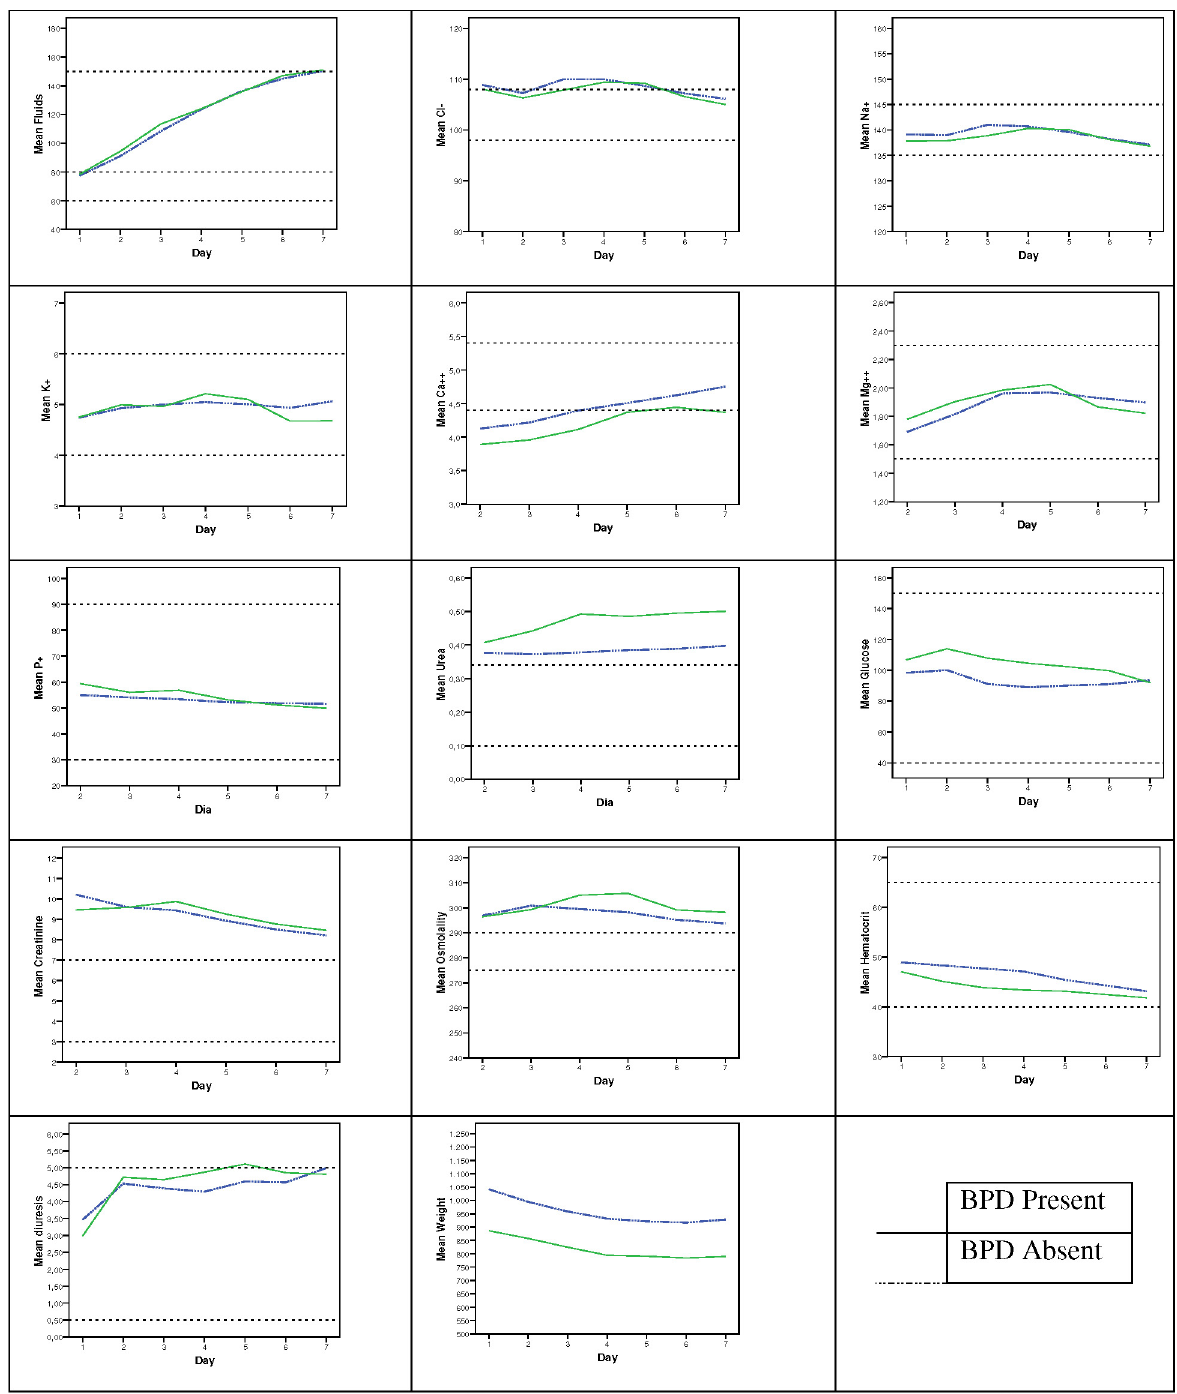
Figure 1 - Graphical representation of the longitudinal variation (first week of life) of the studied parameters in BPD and non-BPD